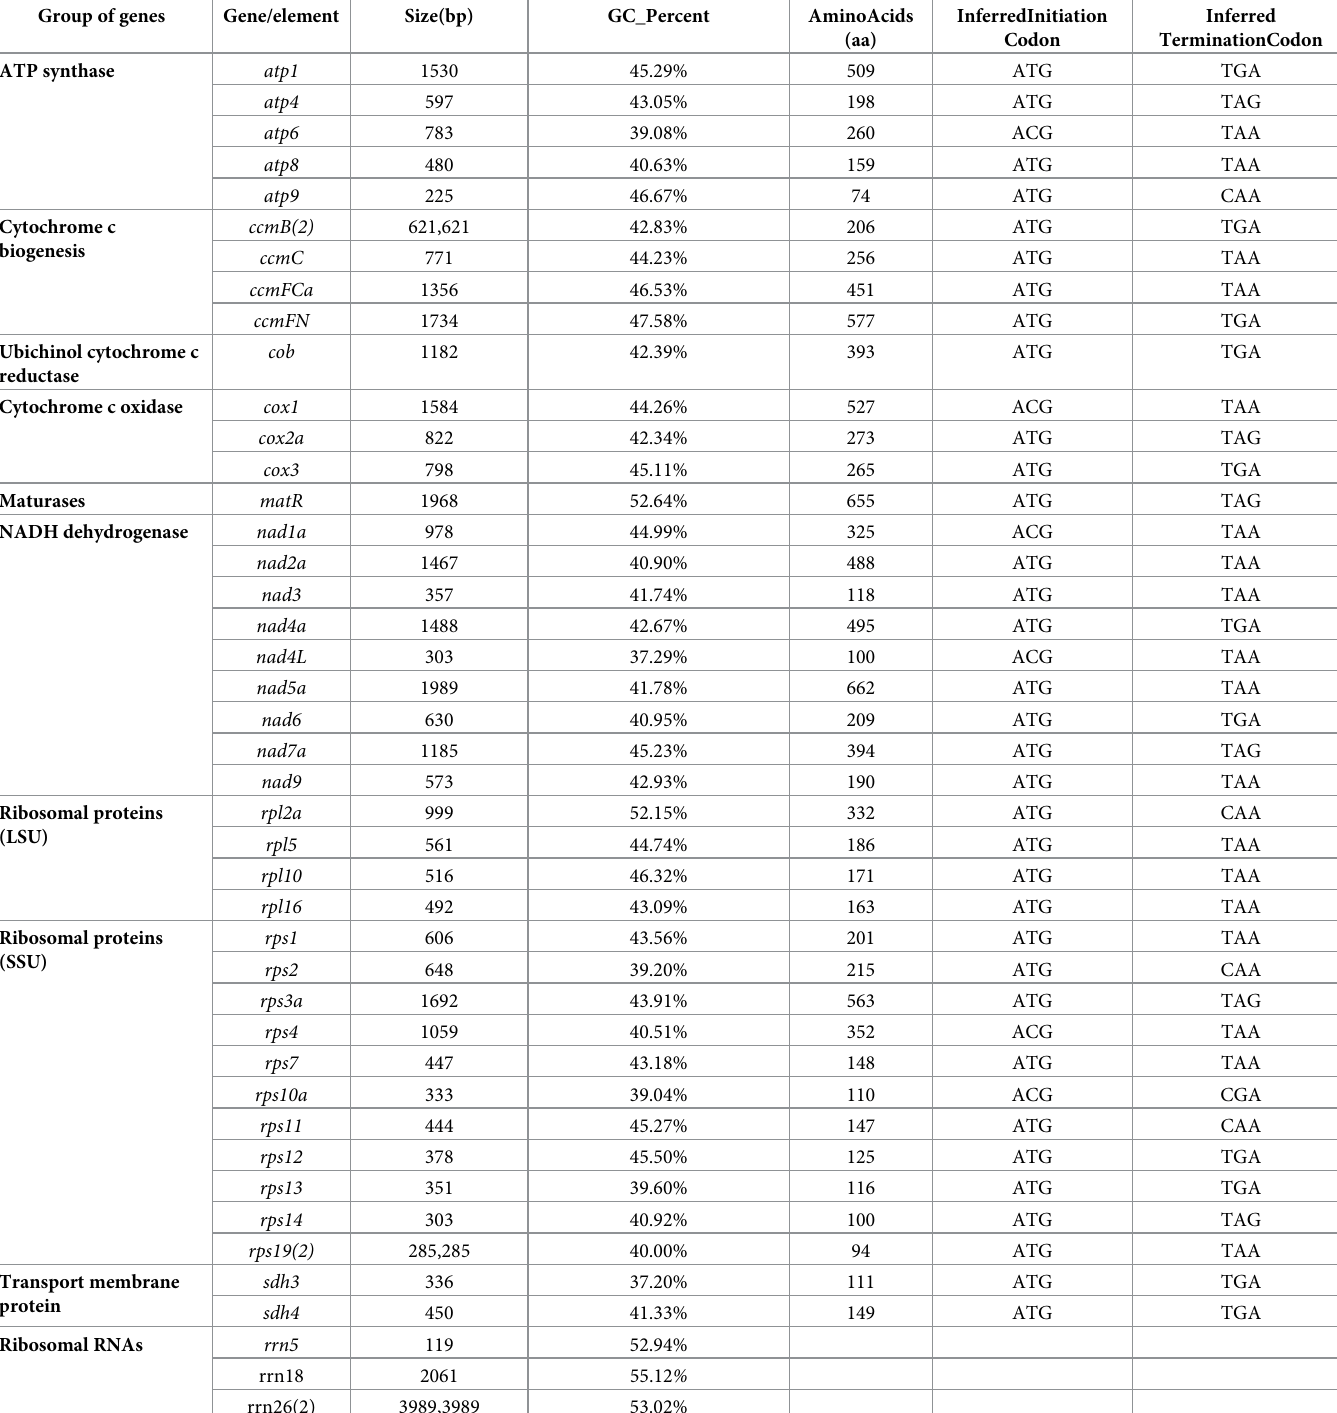
Table 1. Gene profile and organization of three Macadamia species ( M . integrifolia , M . ternifolia and M . tetraphylla ). Group of